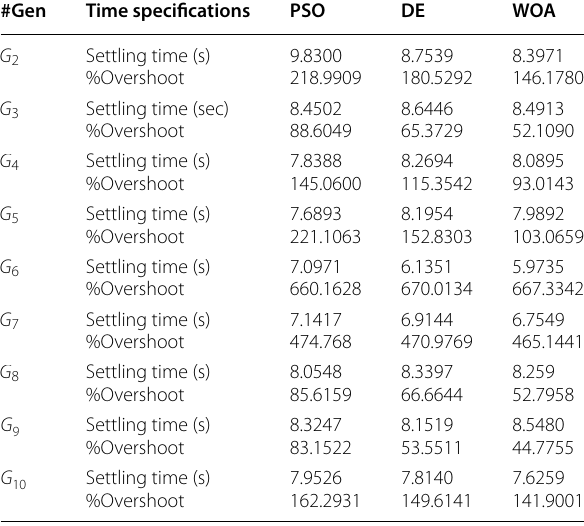
Table 9 Time response specifications of generators